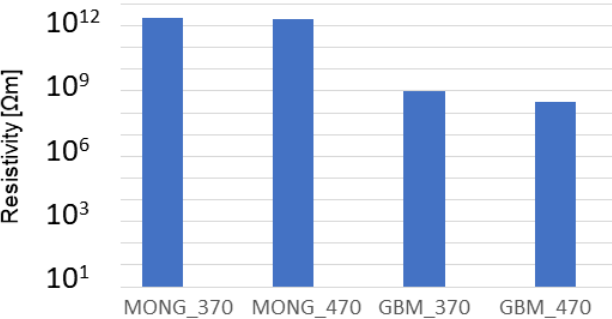
Figure 17. DC volume resistivity of the samples.